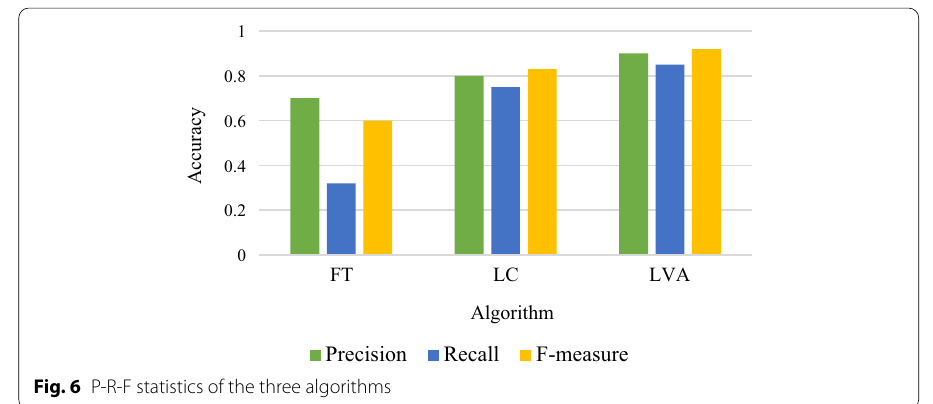
Fig. 6 P-R-F statistics of the three algorithms